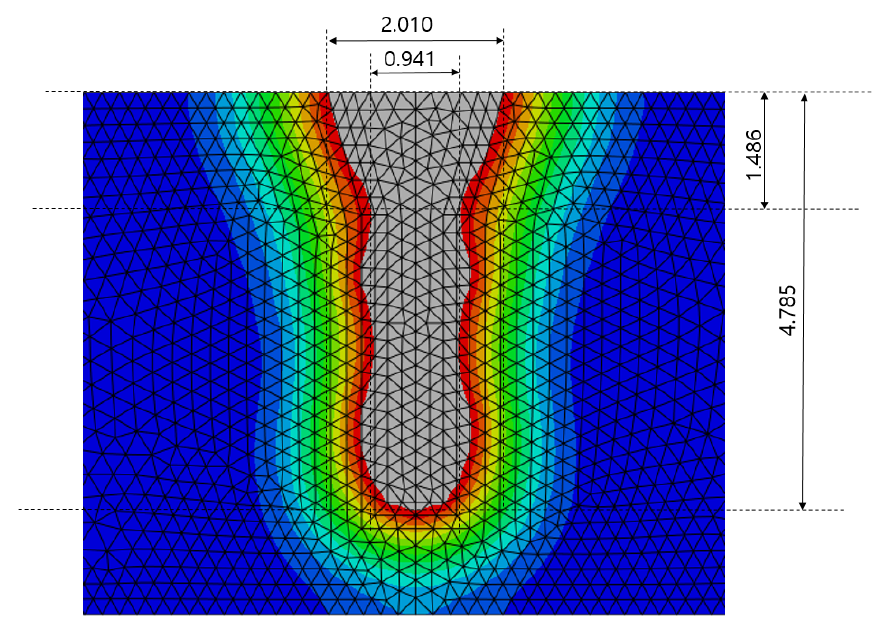
Figure 12. Heat transfer analysis results per welding speed (2.0 m/min).